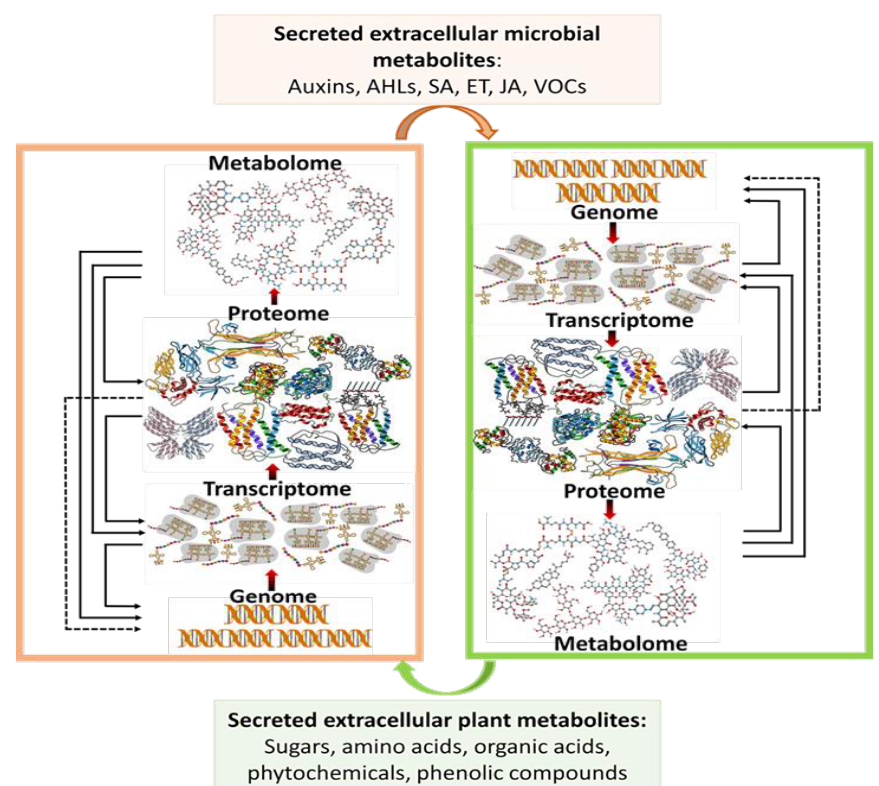
Figure 1. Flow of biological information across a systems biology pipeline. The figure illustrates the integrated flow of biological data through the omics system, beginning at the genome level through the metabolome. The latter creates a link between the functional phenotype and the genome, where an altered genome results in a qualitative or quantitative reprogramming of the metabolome. The intricate process allows for the regulation of cellular metabolism and maintaining homeostasis. Sec- ondly, illustrated is the inter-organismal communication between plants and microbes. The depicted interaction creates a feedback loop that uses the metabolome of the plant and that of the microbe such as salicylic acids (SA), ethylene (ET), volatile organic compounds (VOCs) and N-acyl homoserine lactones (AHLs) as the primary mode of communication to further effect changes in the genomic level in both organisms.